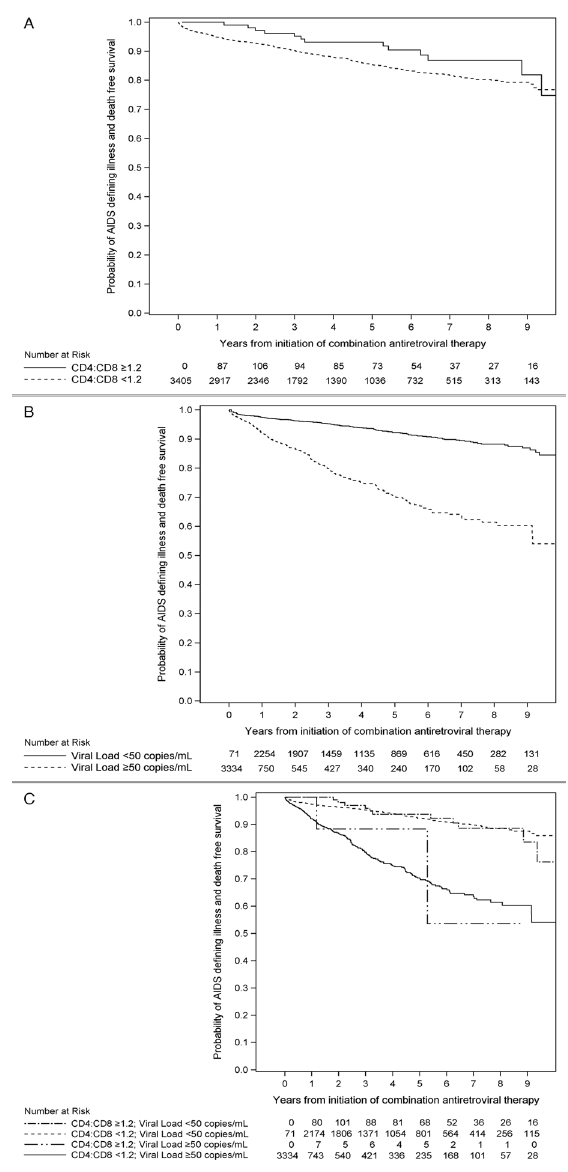
Figure 2. Kaplan-Meier curves of time to AIDS-defining illness or death by time updated: a) CD4:CD8 normalization; b) virologic suppression; c) stratification among 4 groups accord- ing to CD4:CD8 normalization, viral load suppression, both, and neither.